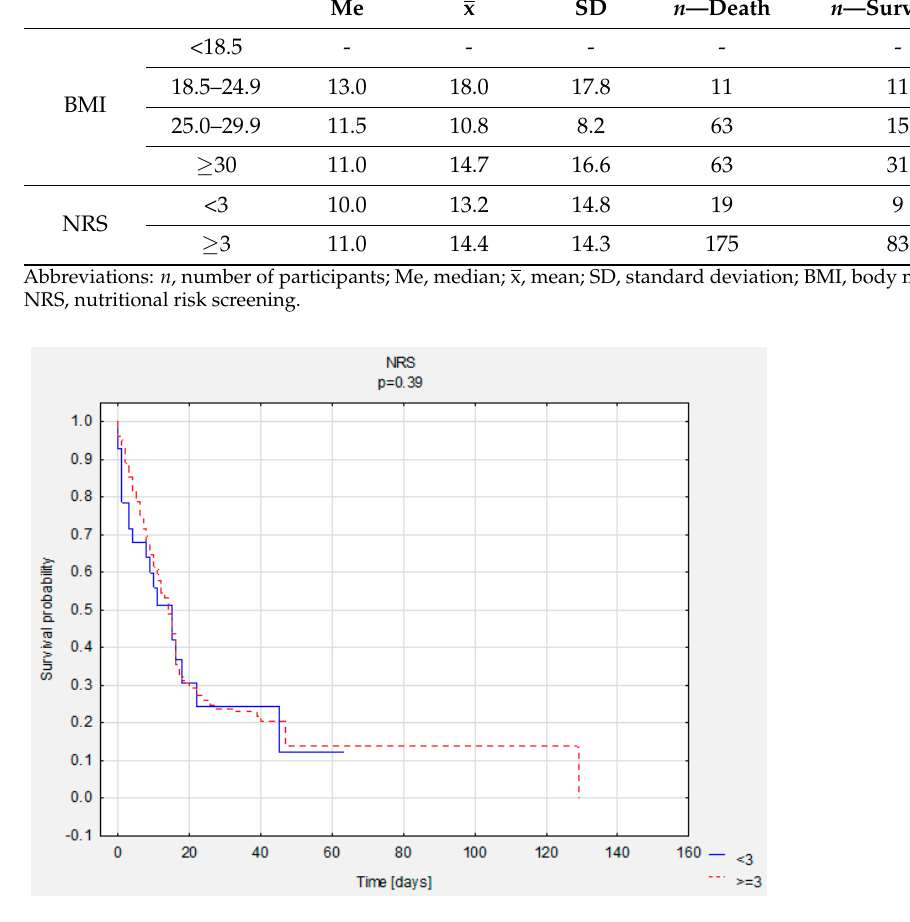
Figure 3. Comparison of survival curves according to NRS scores.